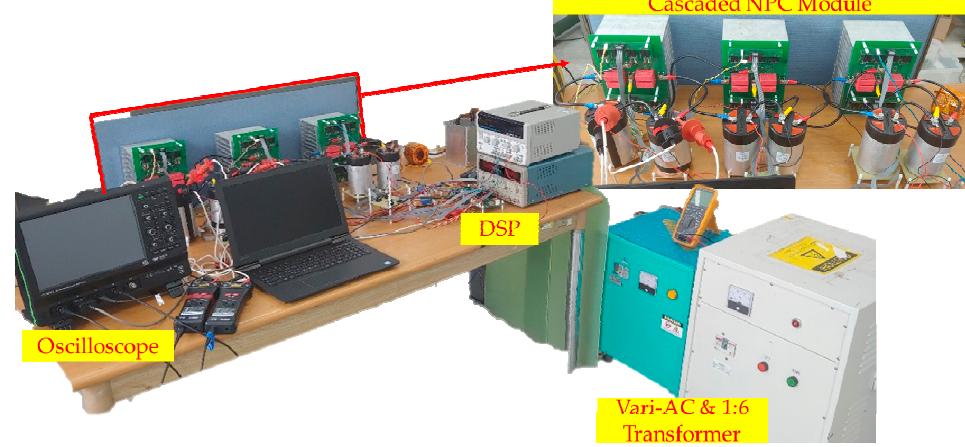
Figure 7. Hardware configuration for cascaded multi-module NPC inverter.